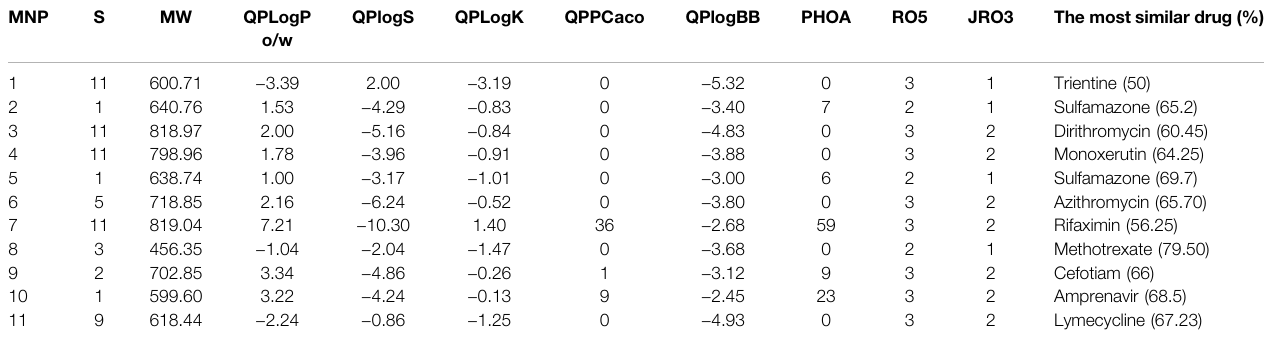
TABLE 6 | ADME parameters and drug similarity of investigated marine natural